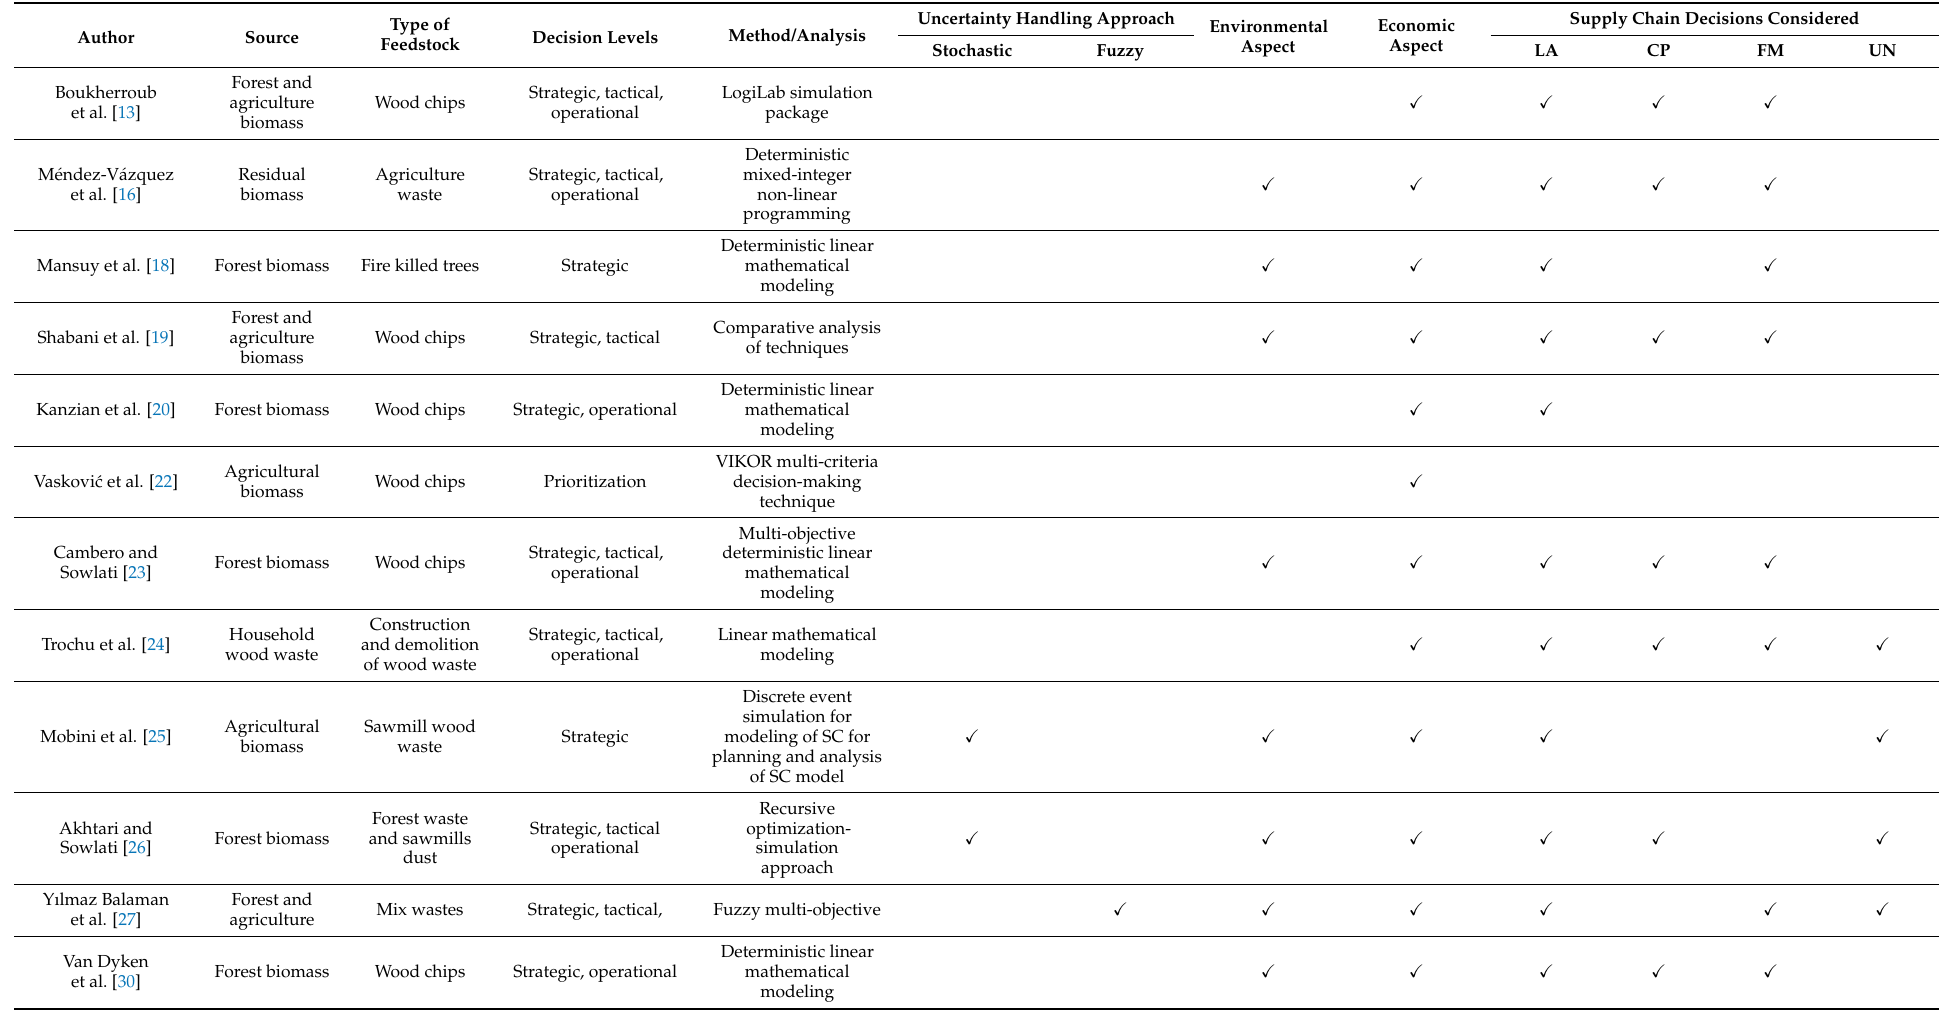
Table 1. Summary of the research related to WPSC network